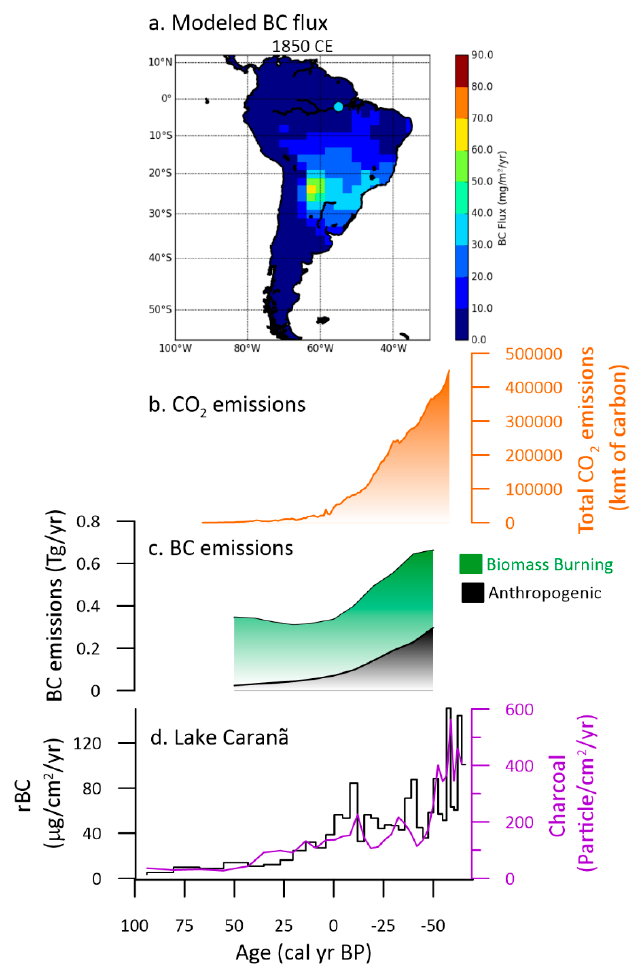
Figure 5. Recent indicators of biomass burning and anthropogenic emissions. ( a ) Black Carbon (BC) model results from Lee et al. [85] for 1850 CE (BC flux in mg m − 2 yr − 1 ) compared to rBC influx from Lake Caranã shown in the circle. ( b ) Total fossil fuel CO 2 emissions from Central America, South America, and Caribbean nations [86]. ( c ) Stacked area chart of Southern Hemisphere South America BC emissions from anthropogenic sources (black) and biomass burning (green) [9]. ( d ) Macrocharcoal (purple) [41] and refractory BC influx (black) from Lake Caranã.